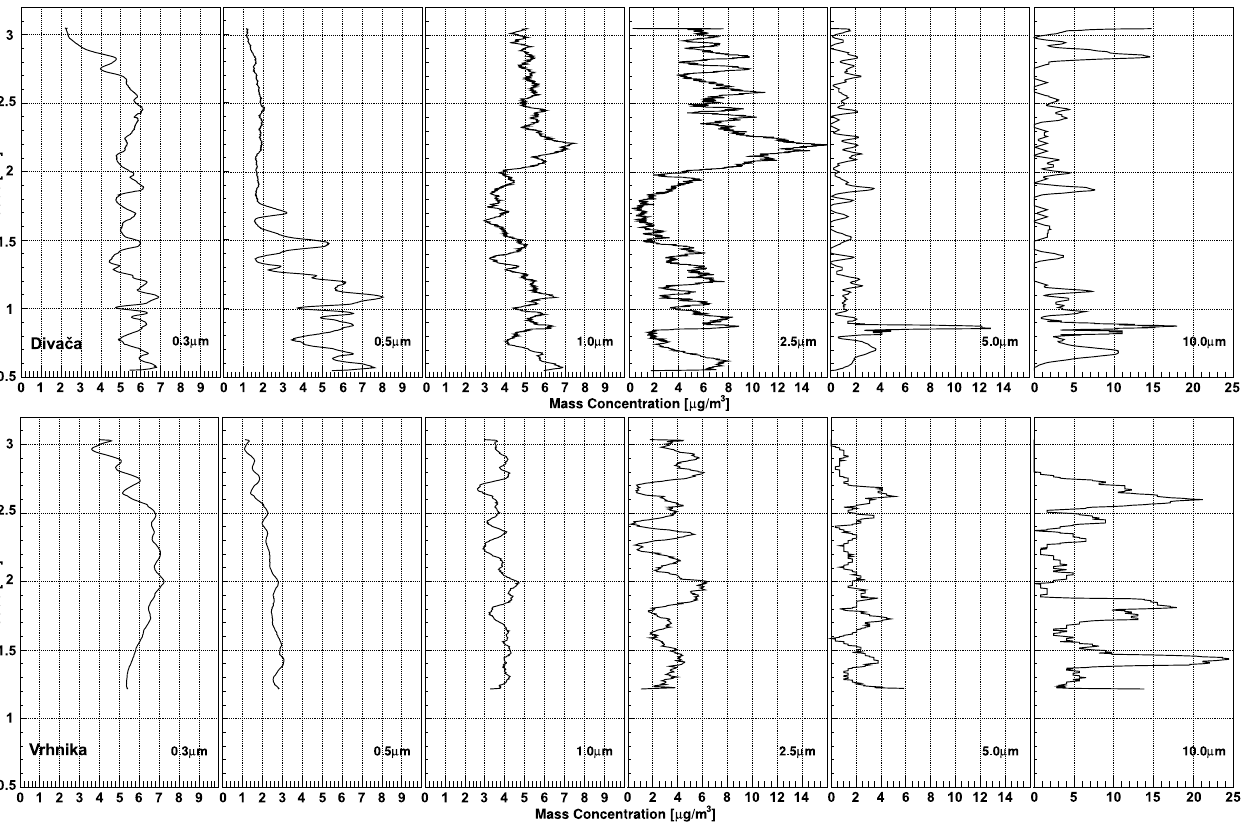
Fig. 7. Variation of peak aerosol backscatter coefficients for the two observed aerosol layers (left) and their corresponding altitudes (right) measured by the Otlica lidar during the night of 20 April 2010. Each data point represents an observation with 5min integration time (6000 laser shots). For the backscatter coefficient, error bars denote the uncertainty due to the set lidar ratio.